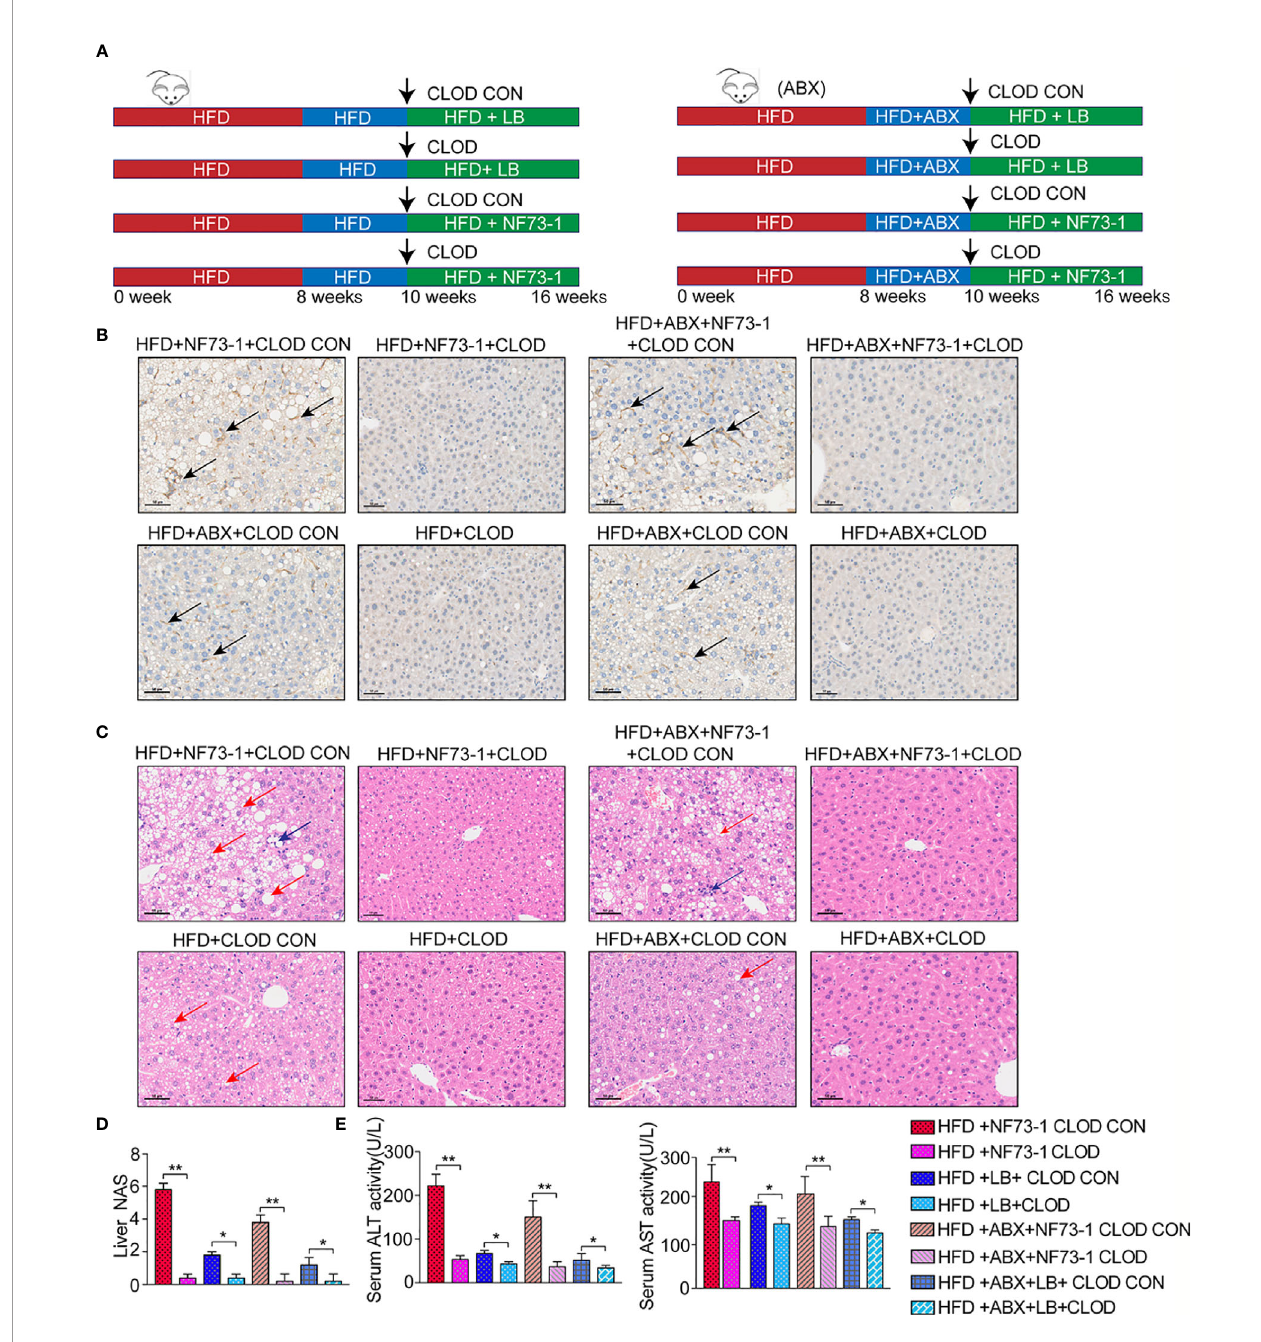
FIGURE 5 | Pharmacological CLOD liposomes prevented E. coli NF73-1 – induced steatohepatitis in NAFLD mice. (A) Schematic illustration of effective CLOD liposomes and control CLOD liposomes in the HFD and HFD-ABX groups with or without treatment with E. coli NF73-1. (B) Representative immunohistochemistry images for F4/80 in livers from the HFD-NF73-1, HFD-LB, HFD-ABX-NF73-1, and HFD-ABX-LB groups depleted of macrophages by CLOD treatment. (C) Representative H&E images of livers (blue arrows, in fl ammatory cells; red arrows, steatosis); black scale bar indicates 50 m m. (D) NAS analysis of liver samples. (E) Sreum ALT and AST in each group. Data are calculated as the mean ± SEM, n = 4 – 6 per group. *p <0.05, **p <0.01 (unpaired t test). NAFLD, non-alcoholic fatty liver disease; HFD, high-fat diet; ALT, alanine aminotransferase; AST, aspartate aminotransferase; H&E, hematoxylin & eosin; NAS, NAFLD activity score; CLOD, clodronate liposome; CLOD CON, clodronate liposome